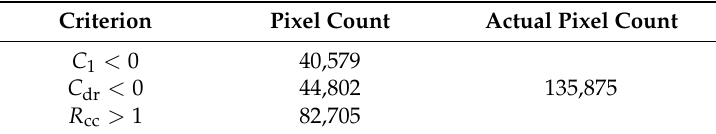
Figure 9. Magnitudes of different criteria and histograms of selected patches: ( a – c ) the magnitudes of C 1 , C dr , and R cc respectively; and ( d – f ) the fitting histograms of the four patches. Table 7. Processed pixel statistics of artificial